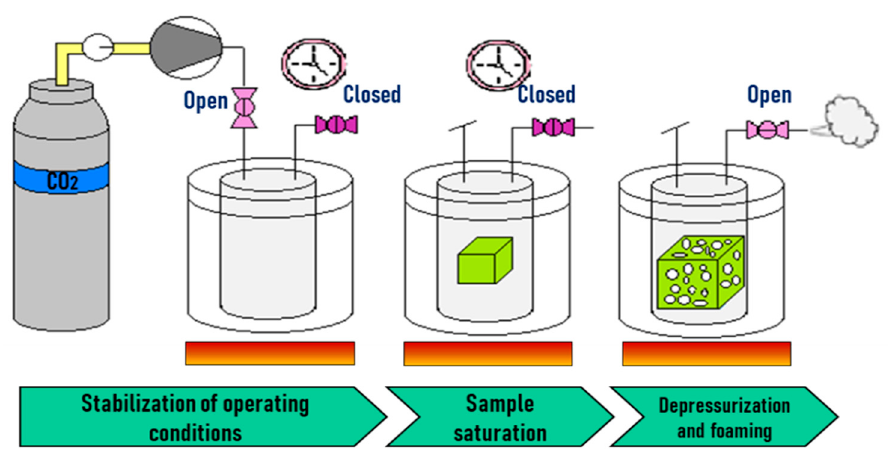
Figure 8. Pressure-induced foaming process. Adapted from Standau et al. [132].